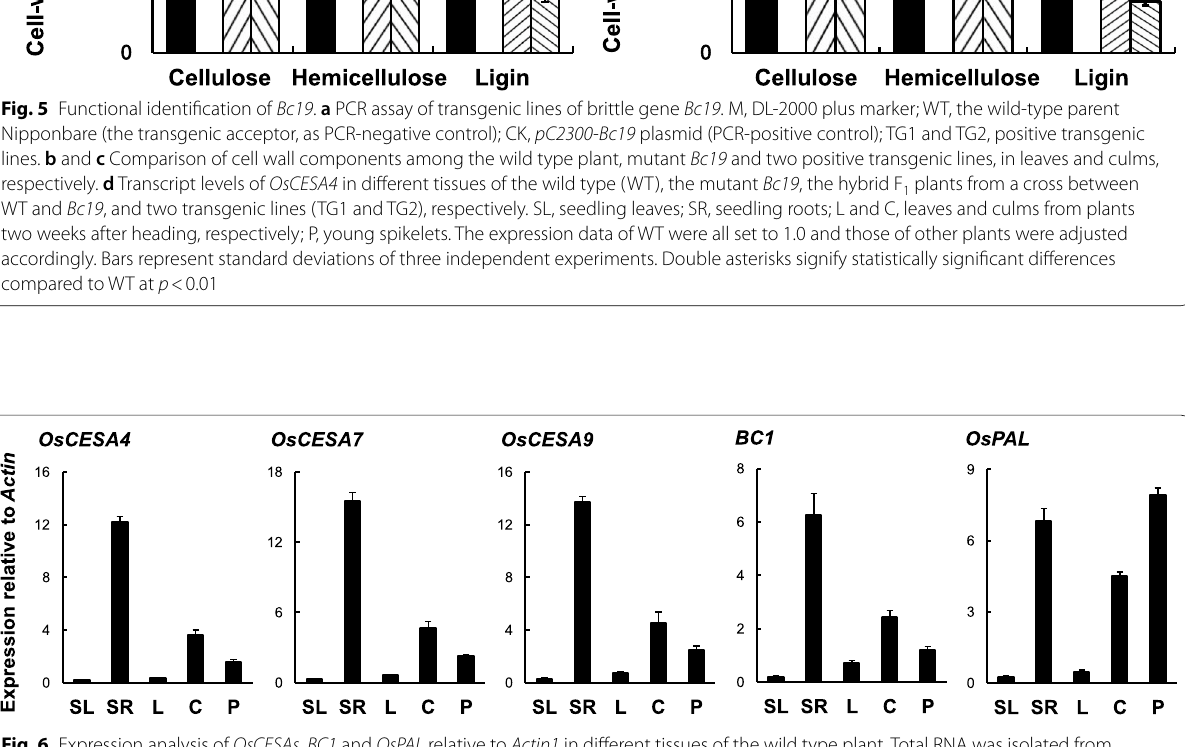
Fig. 6 Expression analysis of OsCESAs , BC1 and OsPAL relative to Actin1 in different tissues of the wild type plant. Total RNA was isolated from seedling leaves (SL), seedling roots (SR), leaves and culms from plants two weeks after heading (L and C), young panicles (P). The rice Actin1 was used as a control. Values represent averages of three independent replicates. Vertical bars show standard